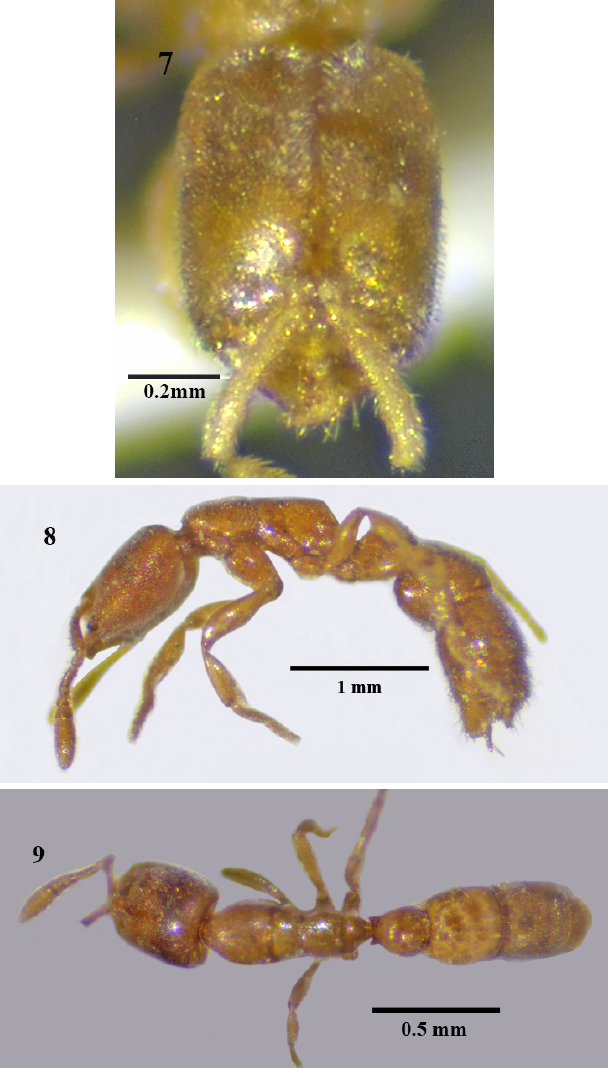
Figures 7-9 . Prionopelta kraepelini Forel, 1905, (7) Head, frontal view; Habitus, (8) lateral view; (9) dorsal